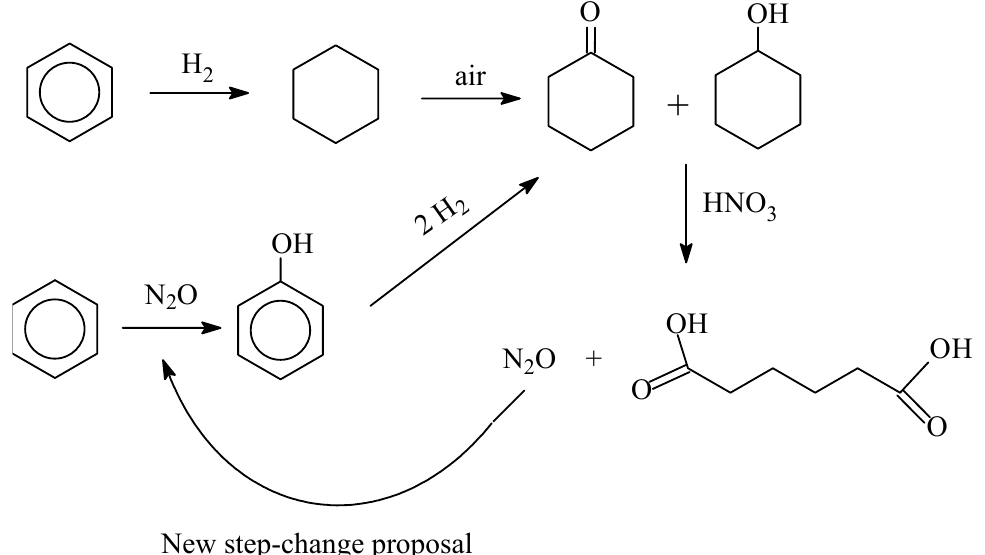
Figure 2: Schematic representation of the possible future role of Fe-MFI catalysts in the adipic acid process, as suggested by Panov et al.